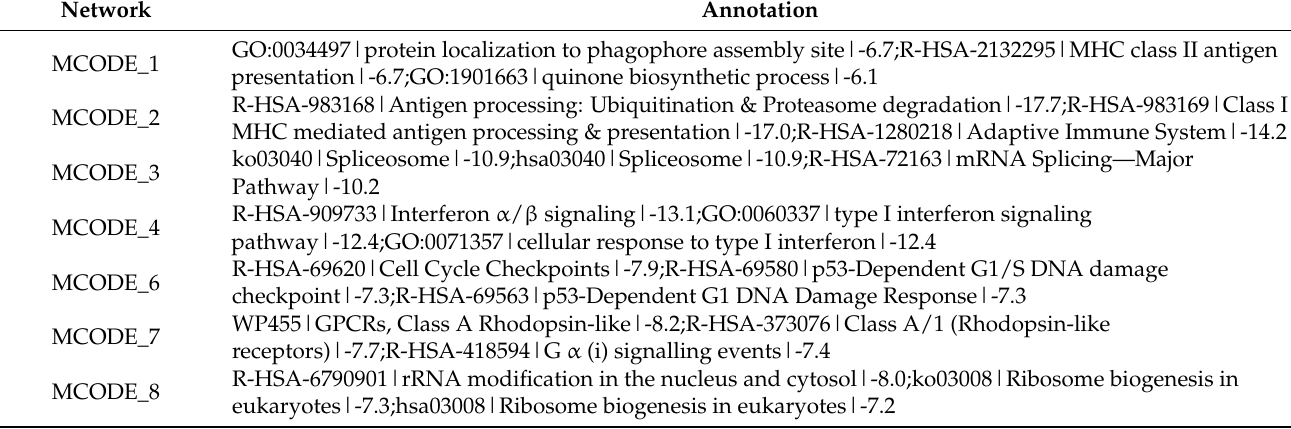
Table 1. Gene Ontology and Pathway analysis for the MCODE subnetworks constructed on the most correlated genes to TSPAN32 in SLE plasmablasts.